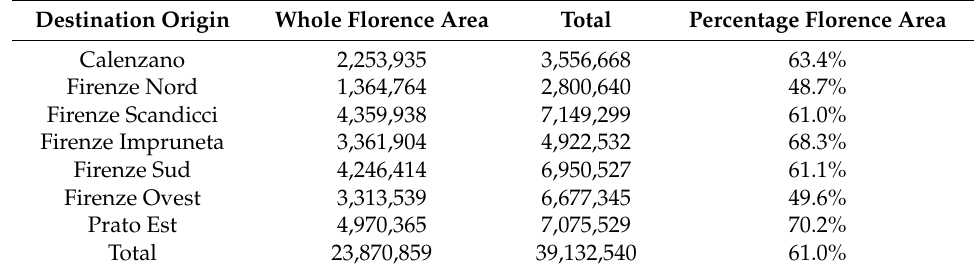
Table 2. Vehicular flows in the Florence area in 2014—total data (source: Autostrade per l’Italia S.p.a.). Destination